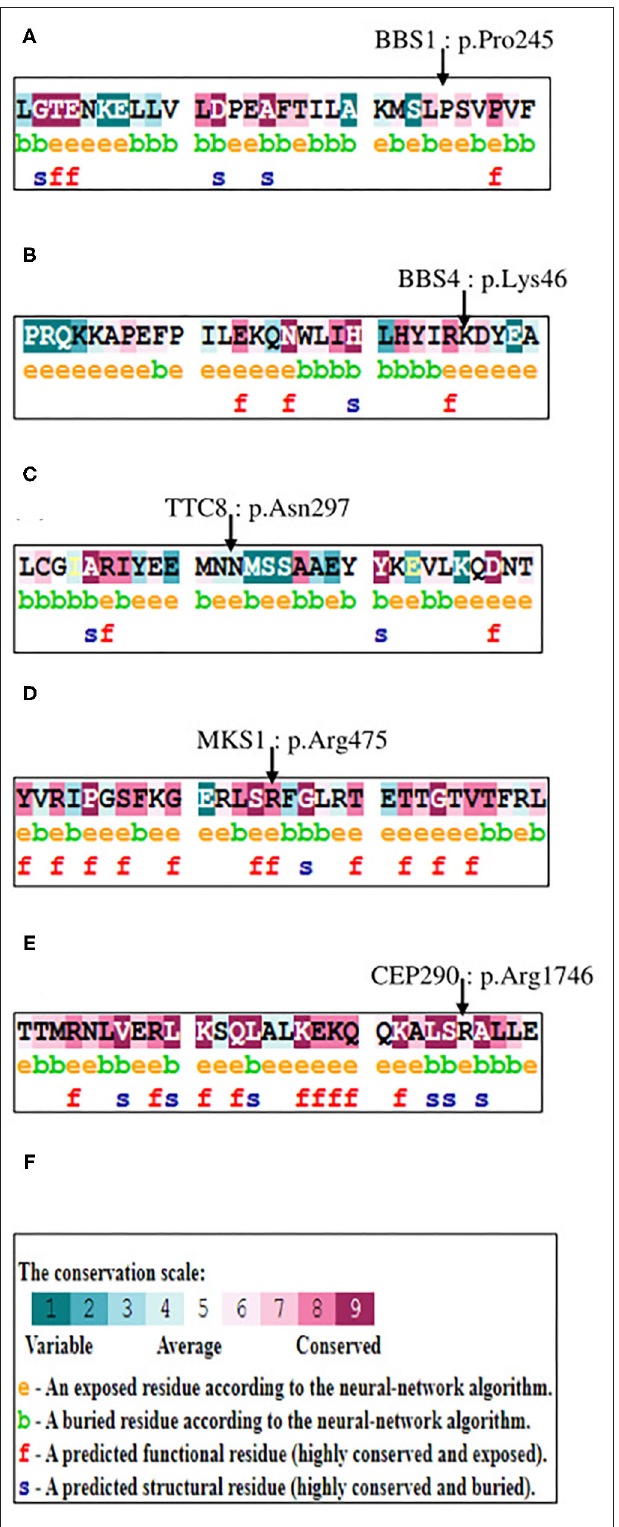
FIGURE 2 | Conservation analyses results by ConSurf software. (A) The amino acid sequence of BBS1 (p.Pro245) is colored based on conservation